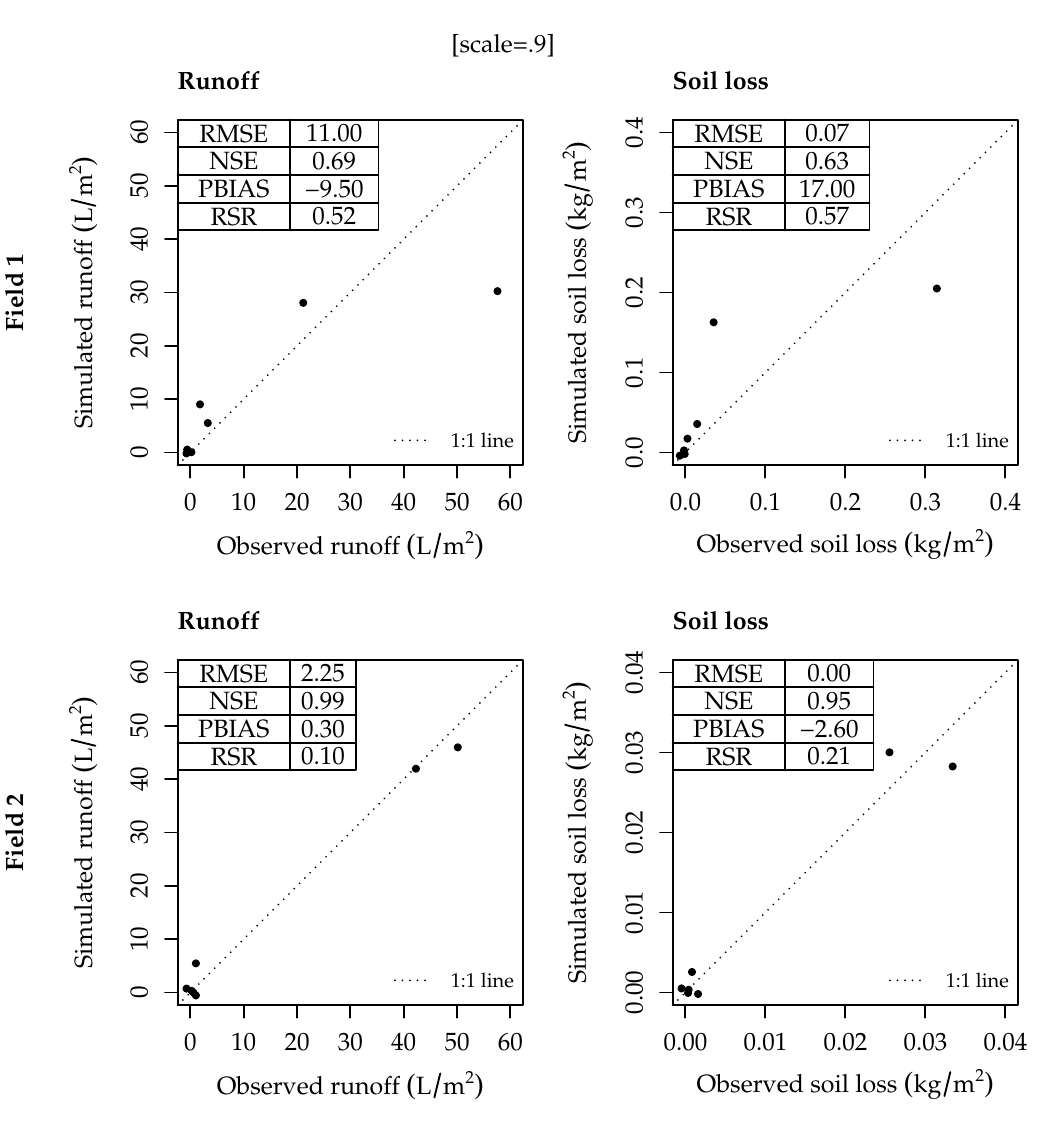
Figure 7. Comparison between simulated and observed runoff ( Q ) and sediment loss ( SL ) for field 1 and field 2. We tested the model performance for both fields with optimized parameters (Table 3). Model performance was evaluated using the Nash-Sutcliffe efficiency coefficient (NSE), percent bias (PBIAS), and RMSE-observation standard deviation ratio (RSR) with the observed data from Arnhold et al. [37]. To make all overlapping points with values close to zero visible, we slightly jitterred the